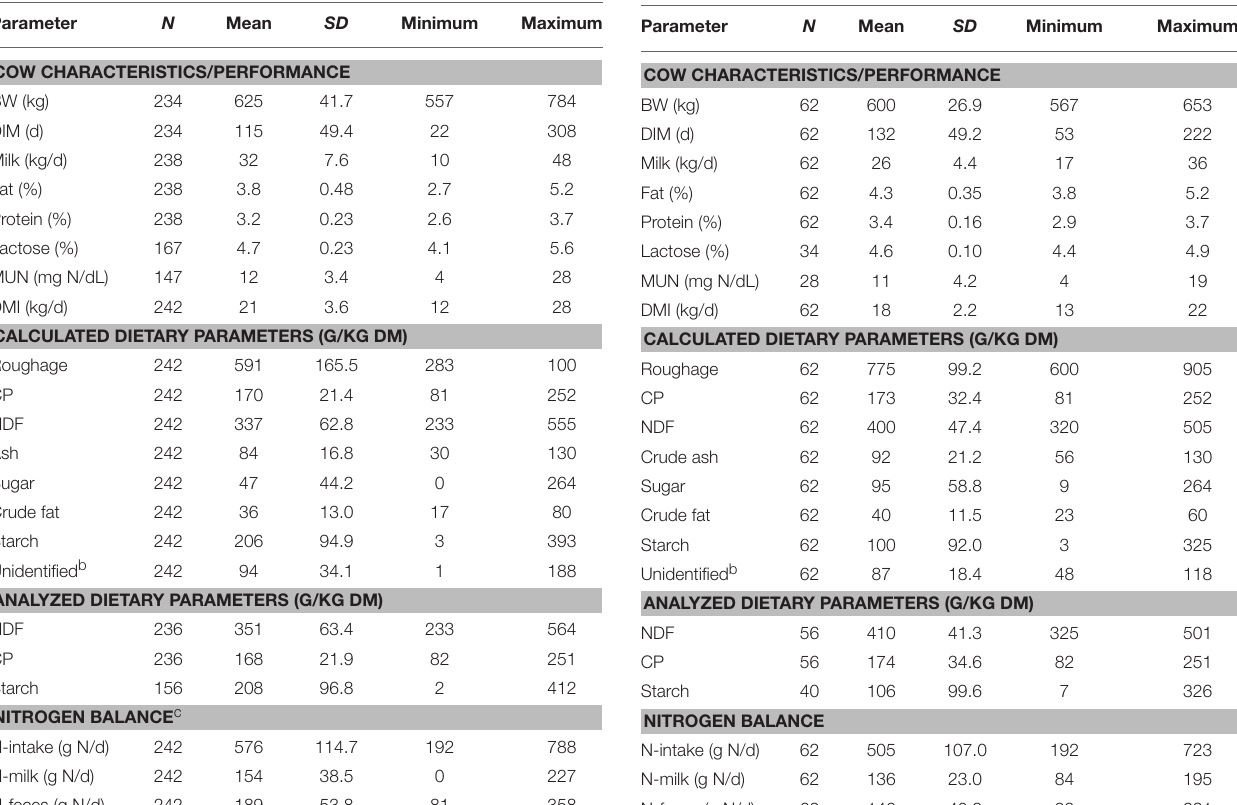
TABLE 2 | Summary statistics of cows and diets in the evaluation dataset, containing Dutch experiments only a